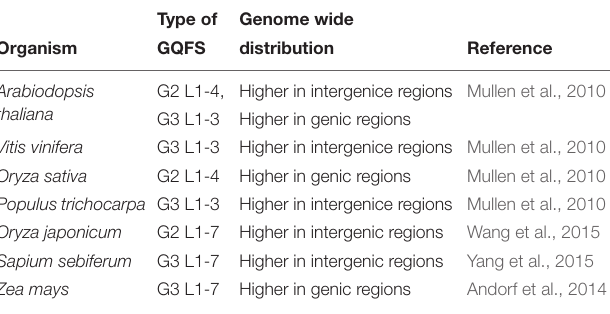
TABLE 2 | Properties of different types of G quadruplex in plant